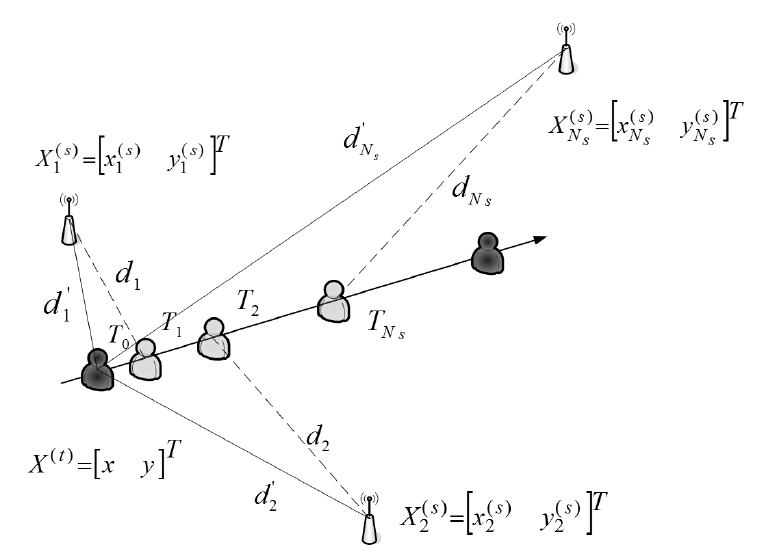
Figure 4. AOA-Aided TOA measurements with multiple